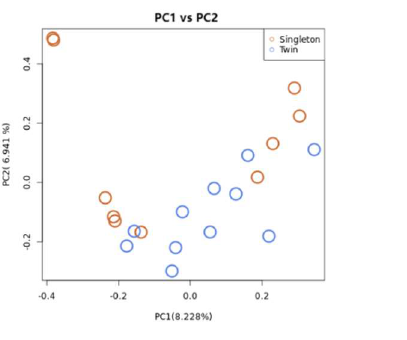
Figure 1. Population genetic diversity. ( A ) PCA plot of Dezhou donkey populations; ( B ) Neighbor- joining phylogenetic tree of Dezhou donkeys; ( C ) Linkage disequilibrium decay analysis.